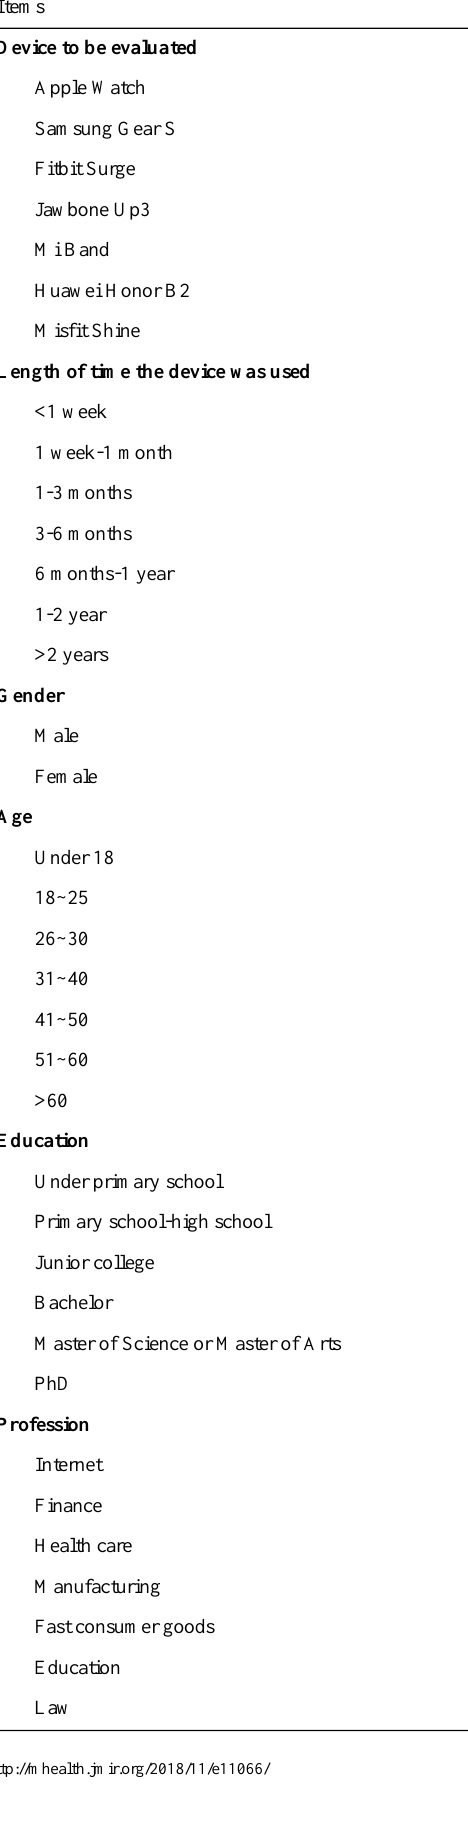
Table 3. Demographic information of the respondents